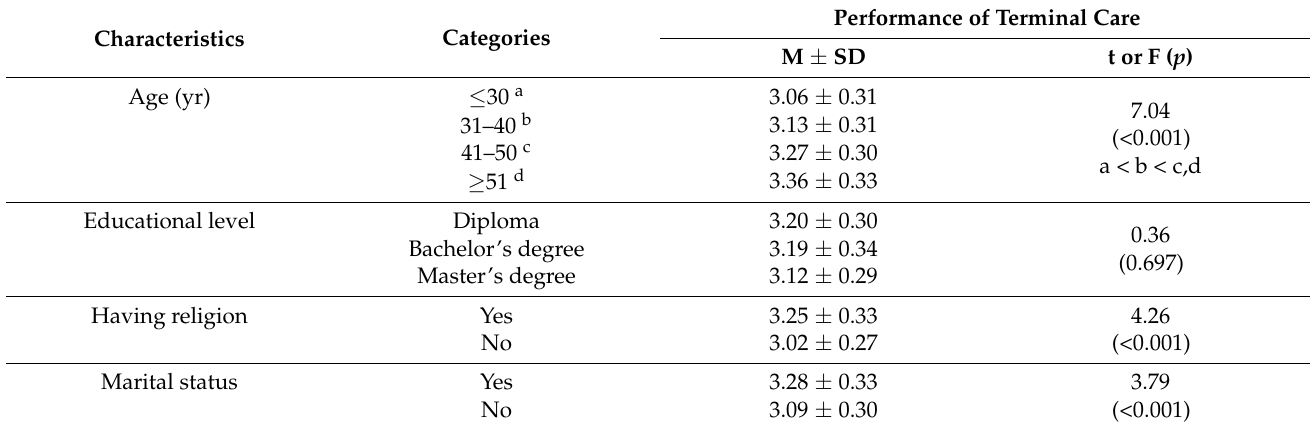
Table 2. Differences in performance of terminal care according to general characteristics ( N =